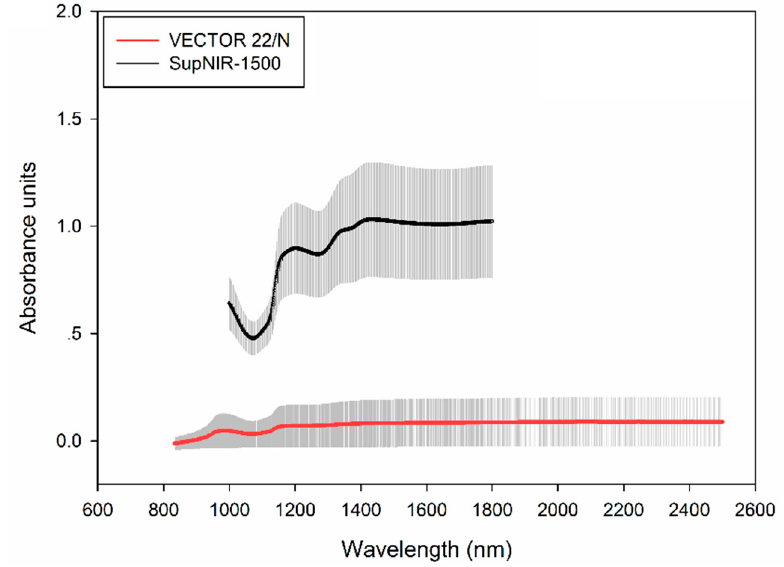
Figure 2. The raw average spectra with standard deviation of Ruby Seedless.